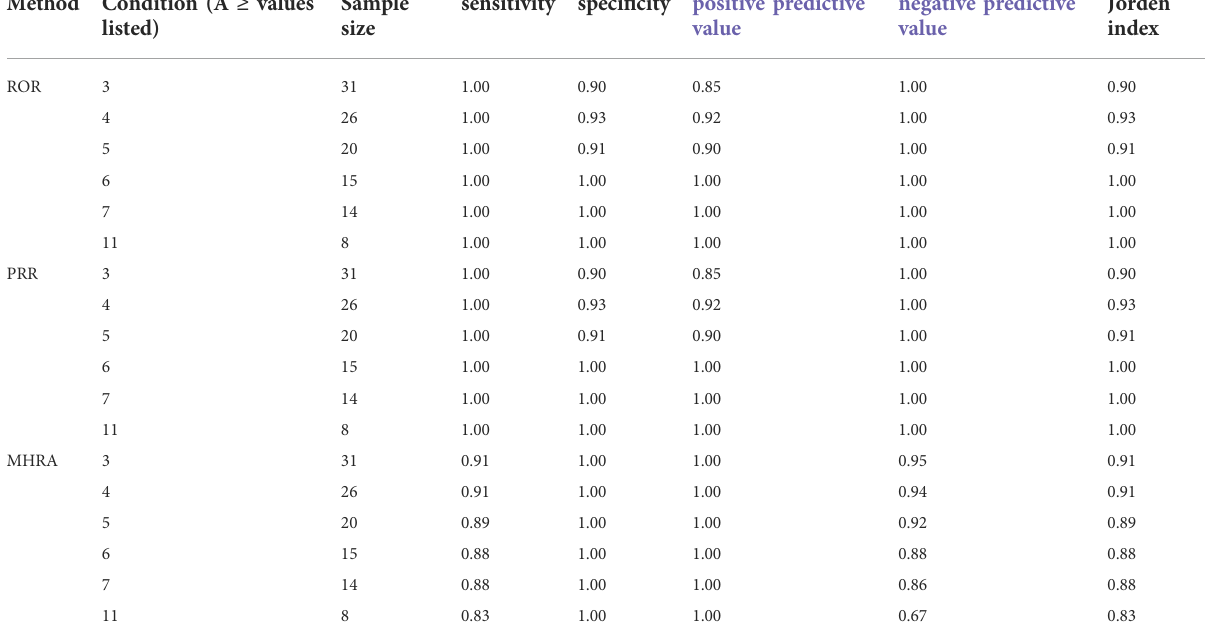
TABLE 6 Comparison of various signal detection methods (Drug-Adverse Events) Method Condition (A ≥ values